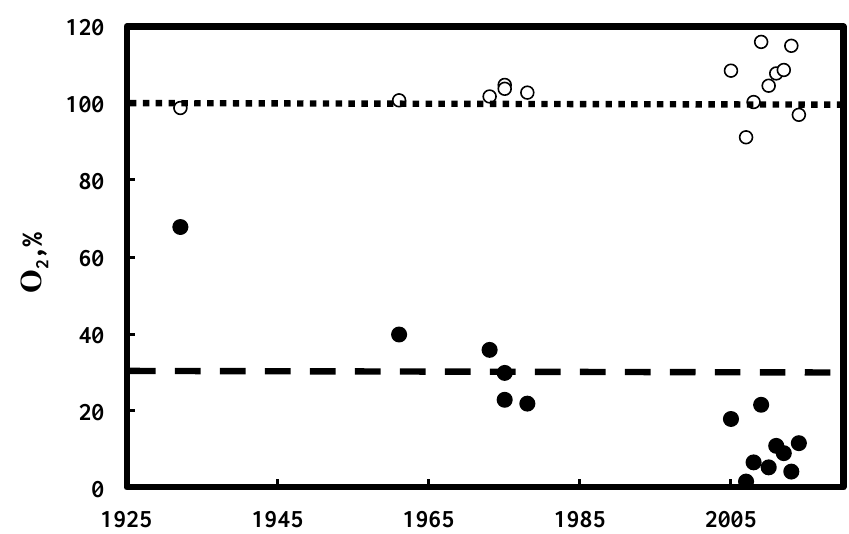
Figure 2. Interannual variability of minimal values of DO concentrations (saturation degree) observed in the bottom waters of Amursky Bay in the summer (filled circles) and corresponding values for surface waters (open circles) [17]. The dashed line corresponds to hypoxia, while the dotted line corresponds to 100%